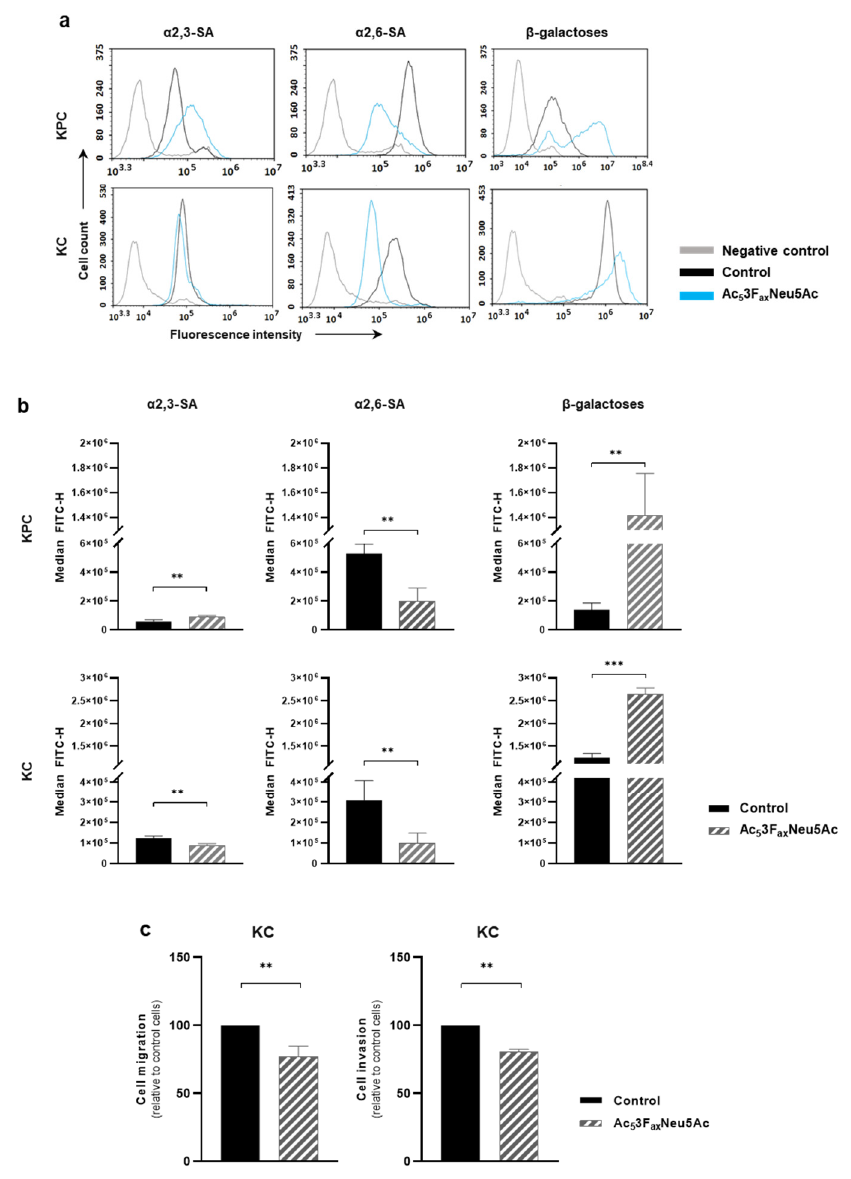
Figure 4. Ac 5 3F ax Neu5Ac reduced sialylation in KPC and KC murine pancreatic cancer cell lines and impaired cell migration and invasion capacity in KC cells. ( a ) Representative histograms showing expression levels of α 2,3-SA, detected by MAA-II lectin; α 2,6-SA, detected by SNA lectin; or terminal β -galactose, detected by PNA lectin; ( b ) Median fluorescence for each glycan structure of treated and control KPC and KC cells are represented; ( c ) KC cells were pre-treated for 72 h with the ST inhibitor and allowed to ( left ) migrate through Collagen type-I coated transwells, for 24 h or ( right ) invade into Matrigel-coated inserts for 48 h. Migrated/invading cells were fixed, stained, and the area occupied by the cells was quantified with ImageJ software. Plots show mean ± SD of at least three independent experiments. ** p < 0.01 and *** p <